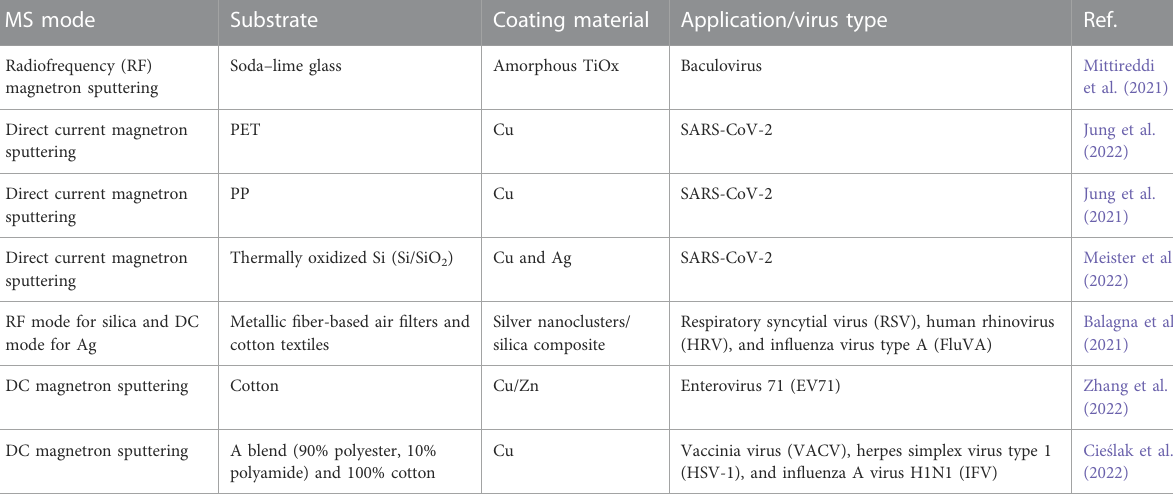
TABLE 3 Applications of magnetron sputtering for antiviral coatings on various